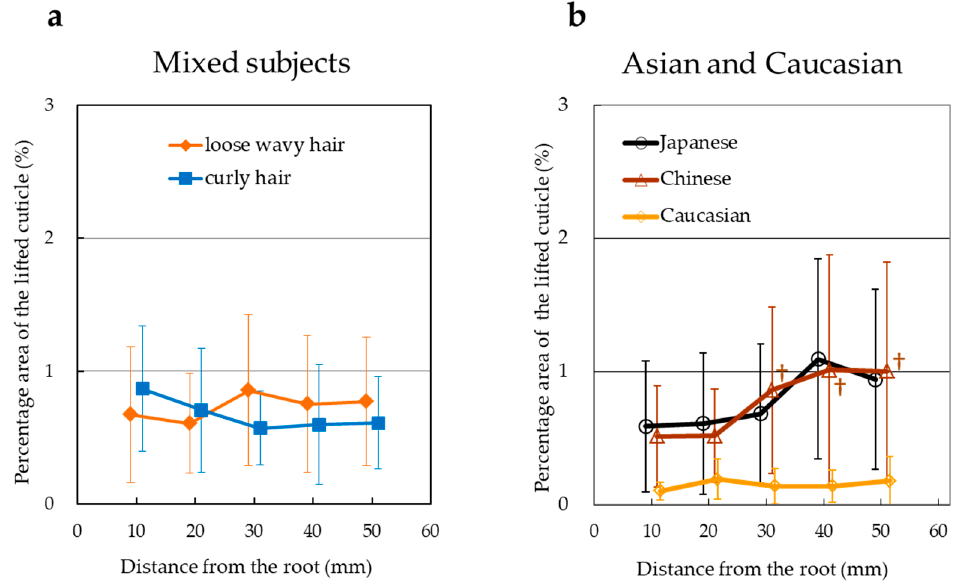
Figure 4. ( a ) The levels of “lifted cuticle” damage of the mixed-race subjects are plotted according to hair shape. There were no statistically significant di ff erences between loose wavy and curly hairs ( p > 0.09). ( b ) The levels of “lifted cuticle” damage of the monoracial subjects. The † indicates statistically significant di ff erences between the marked data and the data at 10 mm ( p < 0.05). 3.3.2. Exposed Endocuticle